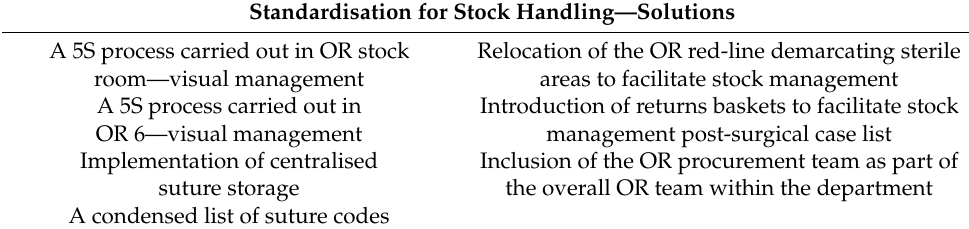
Table 2. Identified and implemented